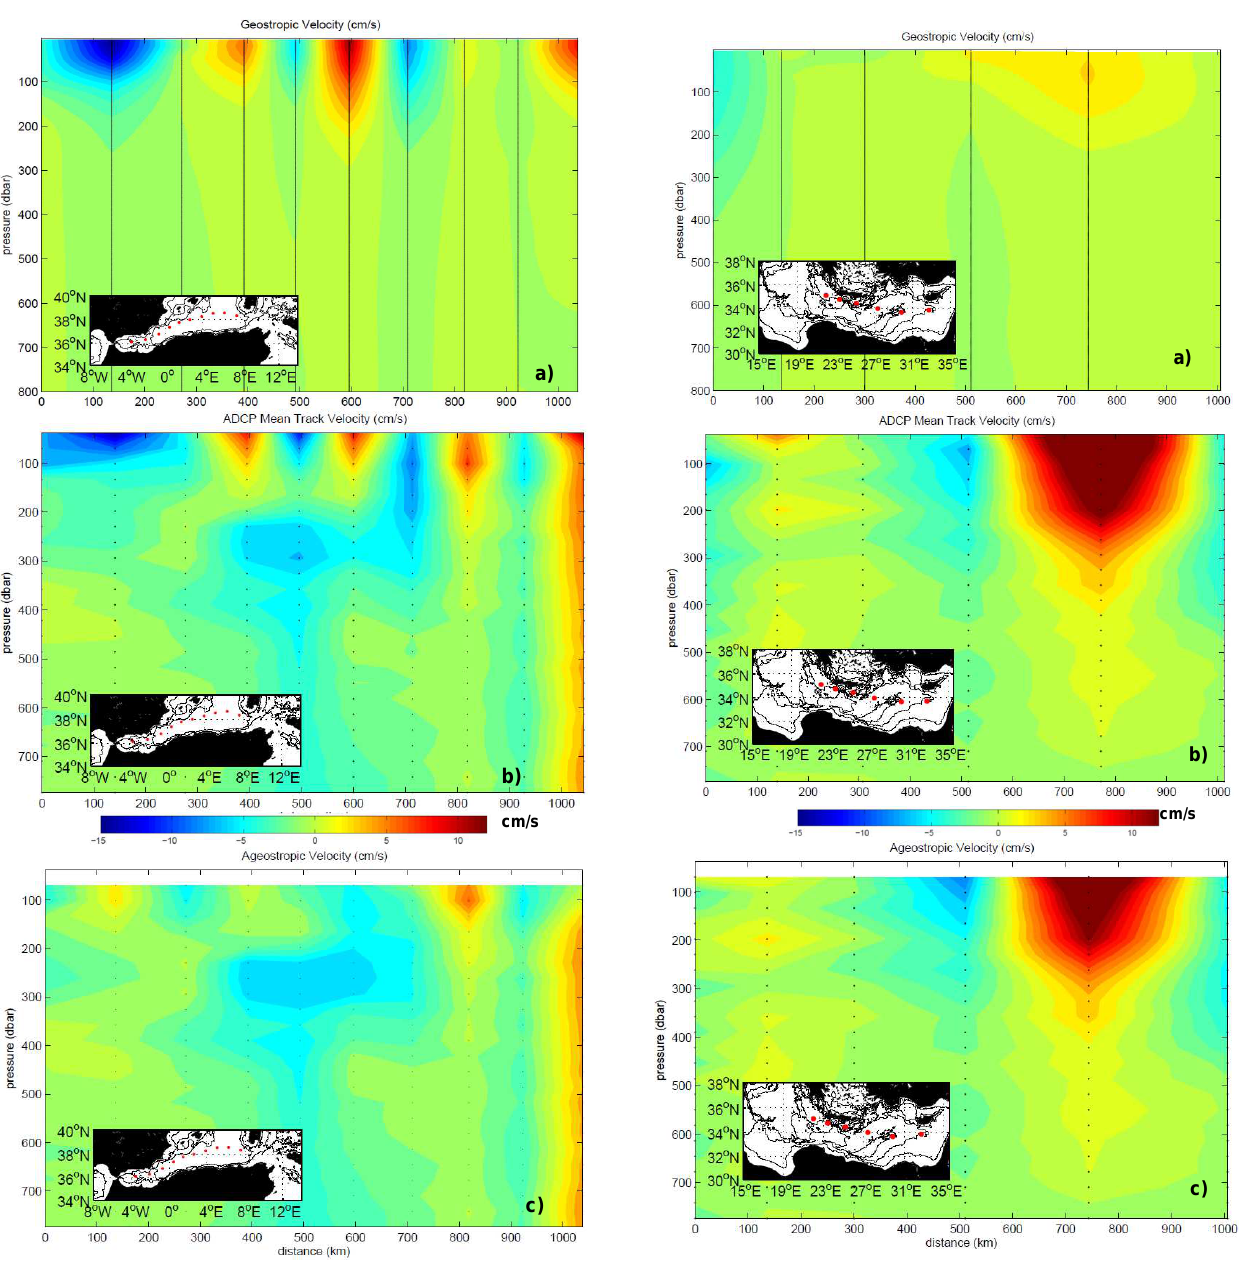
Figure 9. Velocity distribution on a section through the western Mediterranean Sea. The inset panels show the location and nodes of the section. Left axis of panels: depth in dbar; lower axis: distance in km. (a) Geostrophic velocity determined between the CTD sta- tions. (b) Mean ADCP velocity across the section between adjoin- ing CTD stations. Means are calculated between two CTD stations. (c) Ageostrophic velocity determined by subtracting the geostrophic velocity from the mean ADCP velocity. Reference layer of no mo- tion for geostrophic velocities is 1000m.